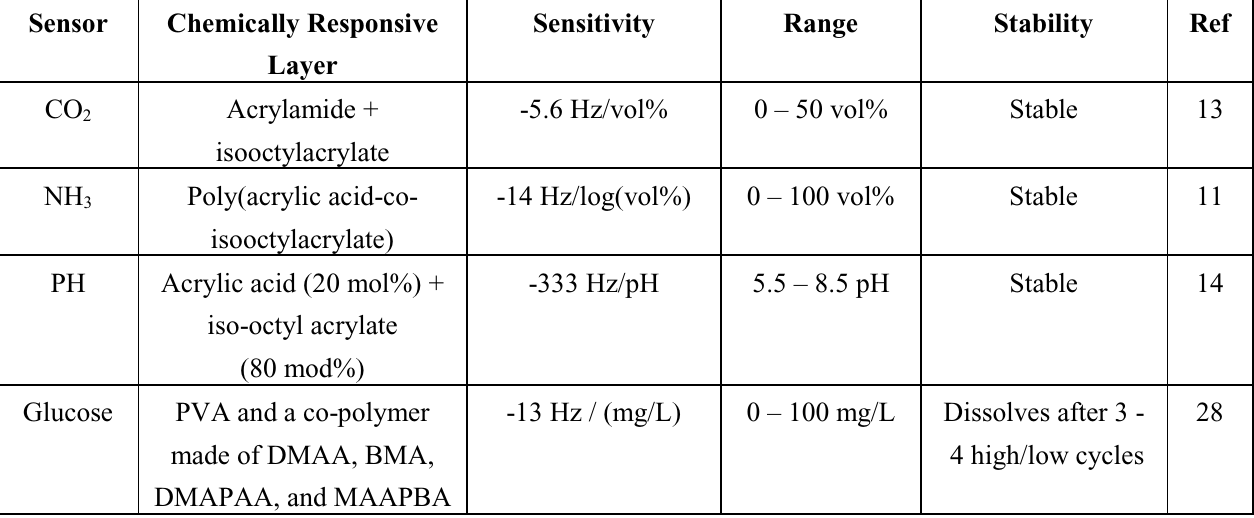
Table 1. Magnetoelastic sensors have been used to monitor CO upon the mass change of chemically responsive